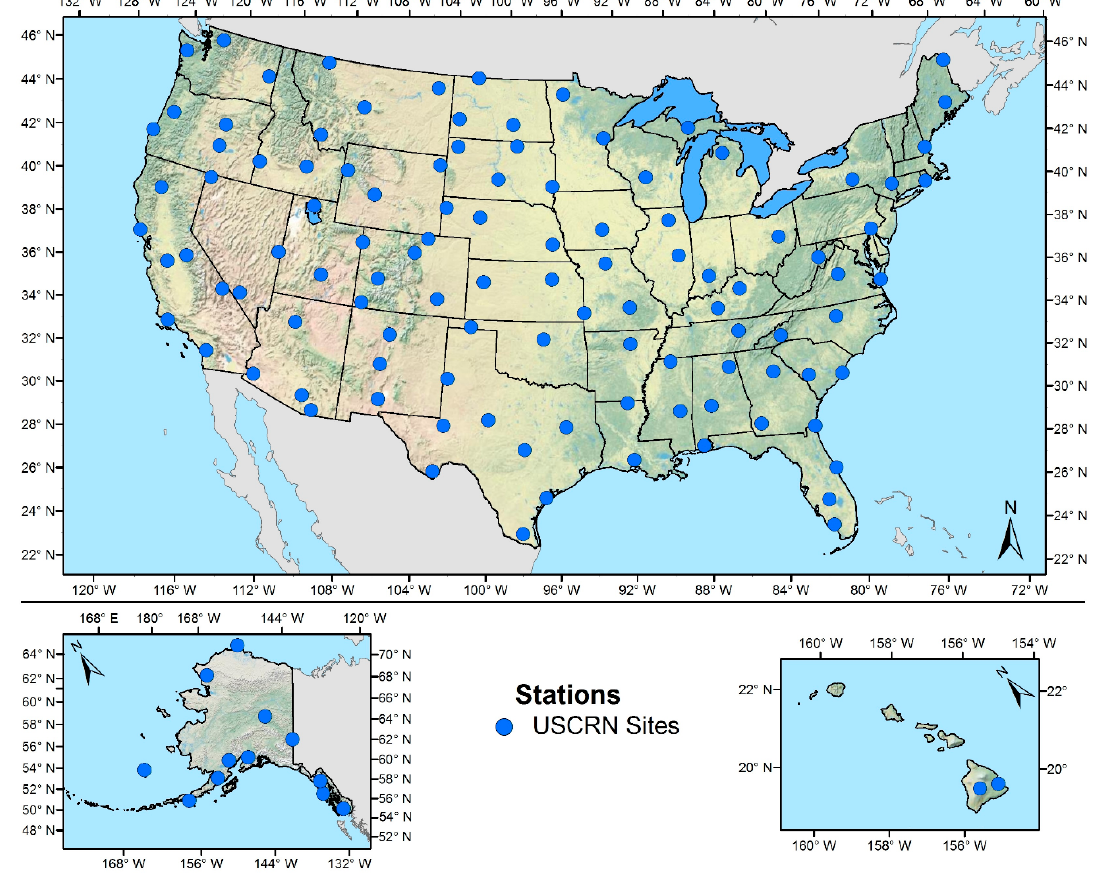
Figure 1. The 2013 locations of stations. Blue circles represent locations of the U.S. Climate Reference Network (USCRN).